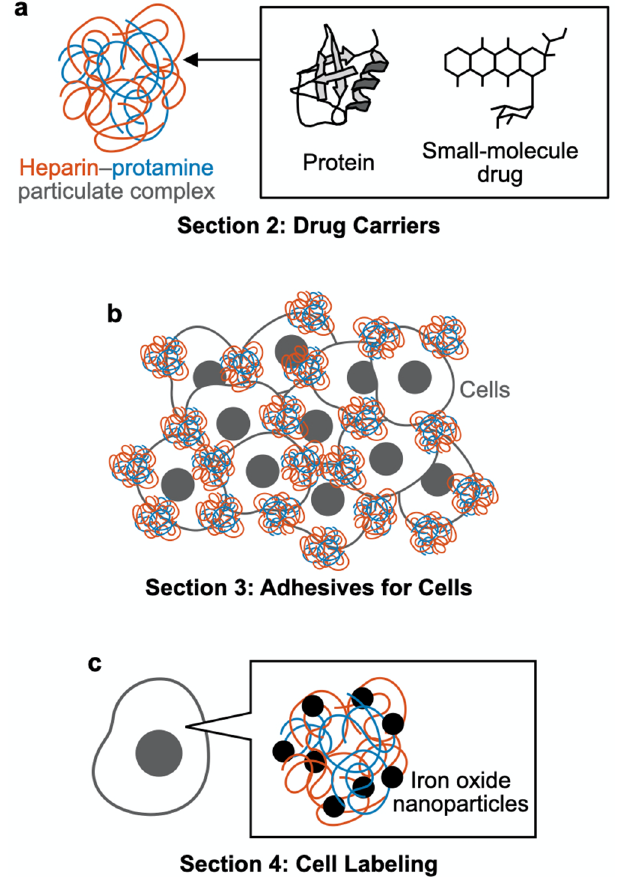
Figure 2. Schematic outline of this review article. ( a ) Section 2: Drug carriers. Heparin–protamine particles are useful as carriers for proteins and small-molecule drugs. ( b ) Section 3: Adhesives for cells. Heparin–protamine particles act as adhesives for cell aggregate formation. ( c ) Section 4: Cell labeling. Heparin–protamine complexes facilitate cell labeling with iron oxide nanoparticles.